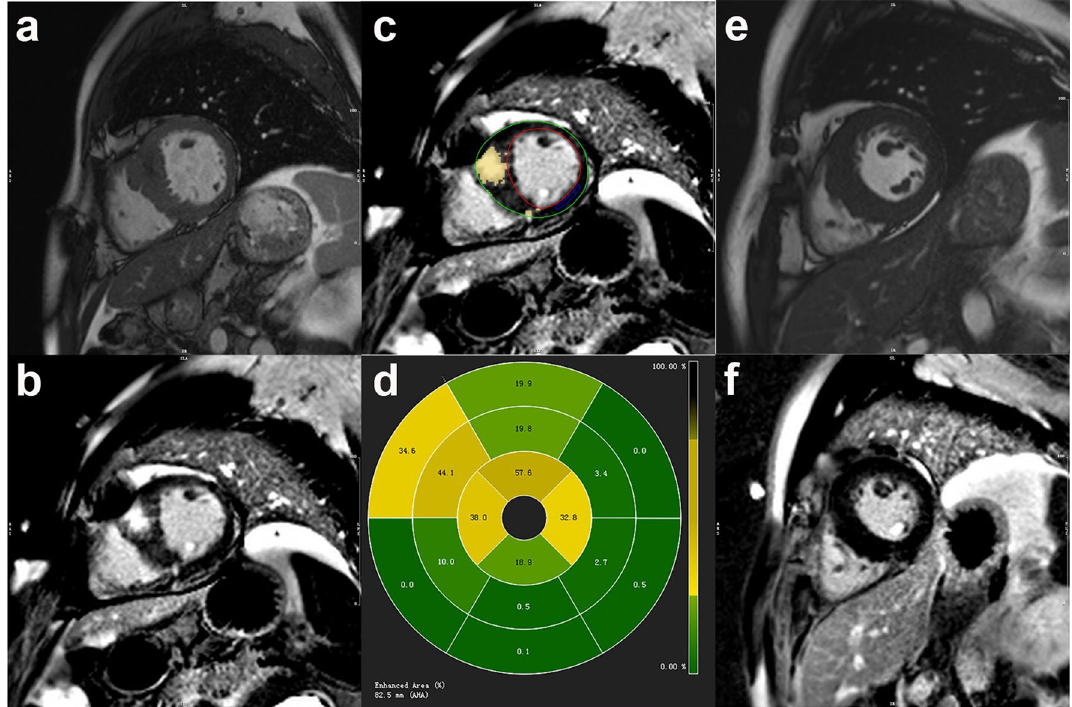
Figure 4. Examples of hypertrophic cardiomyopathy patients with and without LGE. On the left are the short- axis cine ( a ) and LGE images ( b ) in a 46-year-old man. ( c ) Same image showing quantification of LGE using the 6SD thresholding method. ( d ) A representative 16-segment model of the LGE% in this patient. On the right are the short-axis cine ( e ) and LGE images ( f ) in a 46-year-old man without LGE. LGE late gadolinium